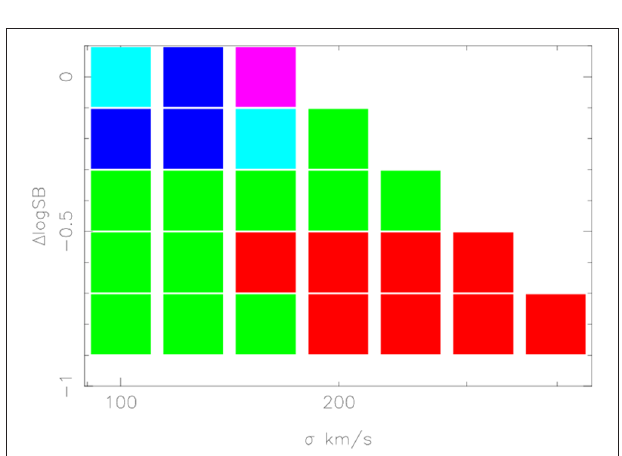
FIGURE 8 | SB excess over the FP as a function of age and σ . Color increments from red through blue are each 0.11 dex in age. Vertical pillars, blue toward the top, are a stellar population fading at constant velocity dispersion.